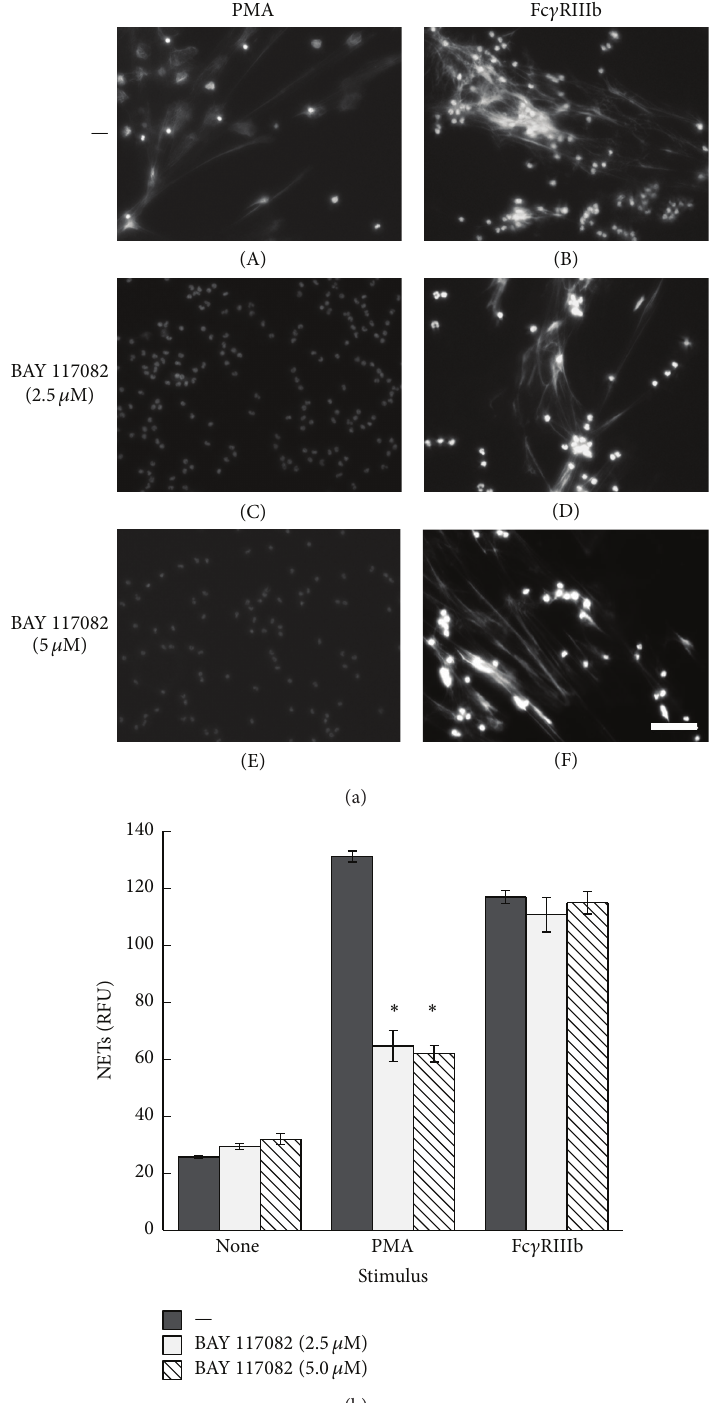
Figure 9: Fc 𝛾 RIIIb-induced NET formation is independent of NF- 𝜅 B. (a) Human neutrophils (PMN) were not stimulated (None) or were stimulated with 20 nM phorbol 12-myristate 13-acetate (PMA) or by cross-linking Fc 𝛾 RIIIb with mAb 3G8. PMN were previously treated with solventalone(—)orwiththeNF- 𝜅 BinhibitorBAY117082at2.5 𝜇 Mand5 𝜇 M.Afterfourhours,PMNwerefixedandstainedforDNA(DAPI). Microphotographs were taken at 200x magnification and are representative of three experiments. Bar is 50 𝜇 m. (b) The relative amount of NETs was estimated from SYTOX Green fluorescence in relative fluorescent units (RFU) at 4 hours after stimulation. Data are mean ± SEM of 4 experiments. Asterisks denote conditions that are statistically different from control ( 𝑝 < 0.05